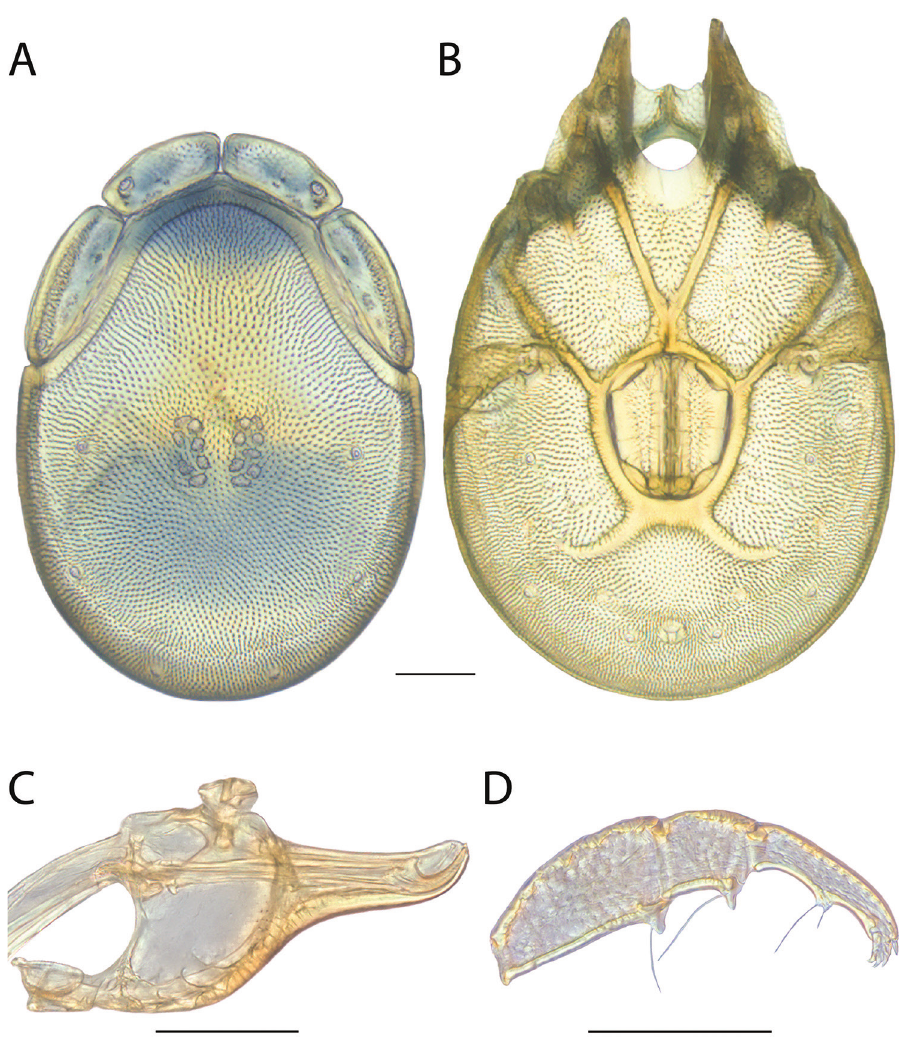
Figure 162. Torrenticola neoanomala female: A dorsal plates B venter (legs removed) C subcapitulum D pedipalp (setae not accurately depicted). Scale = 100